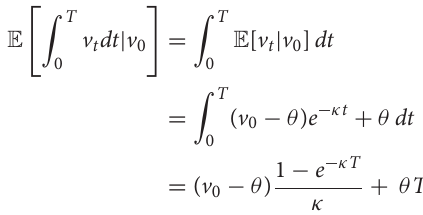
T . The close-up shows the graph along ∈